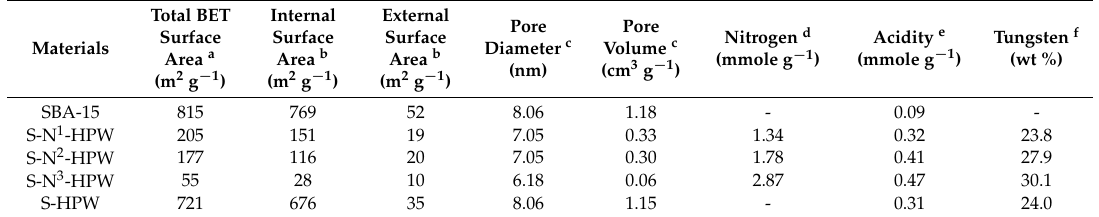
Table 1. Physical and chemical properties of SBA-15, S-N x -HPW, and S-HPW